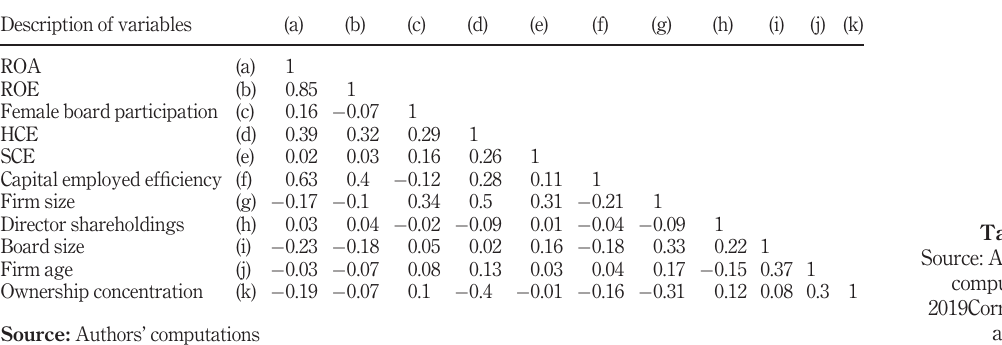
Table II. Source: Authors